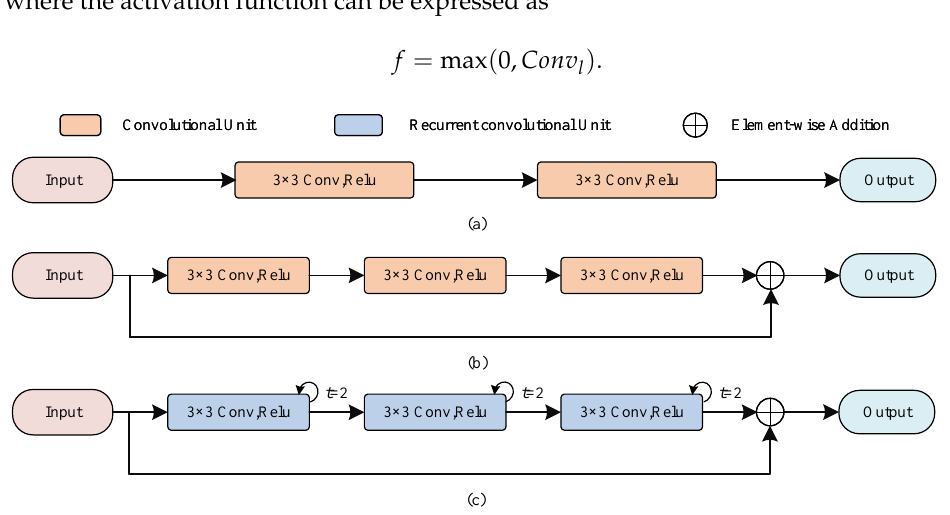
Figure 2. The illustration of RC block and RRC block in our method. ( a ) The encoder in U-Net; ( b ) The residual convolution block; ( c ) The recurrent residual convolution